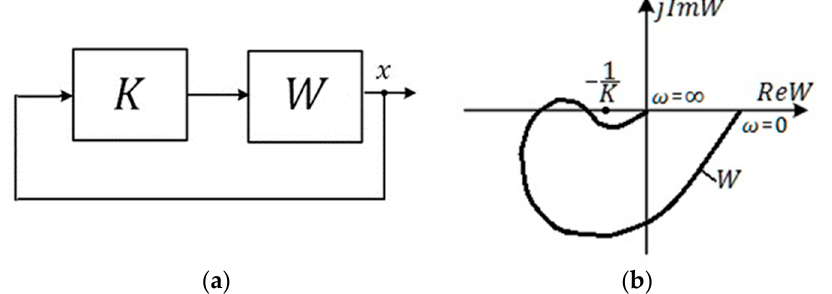
Figure 2. Scheme of the ACS ( a ) and Nyquist stability conditions for the frequency hodograph of the ACS open part ( b ).